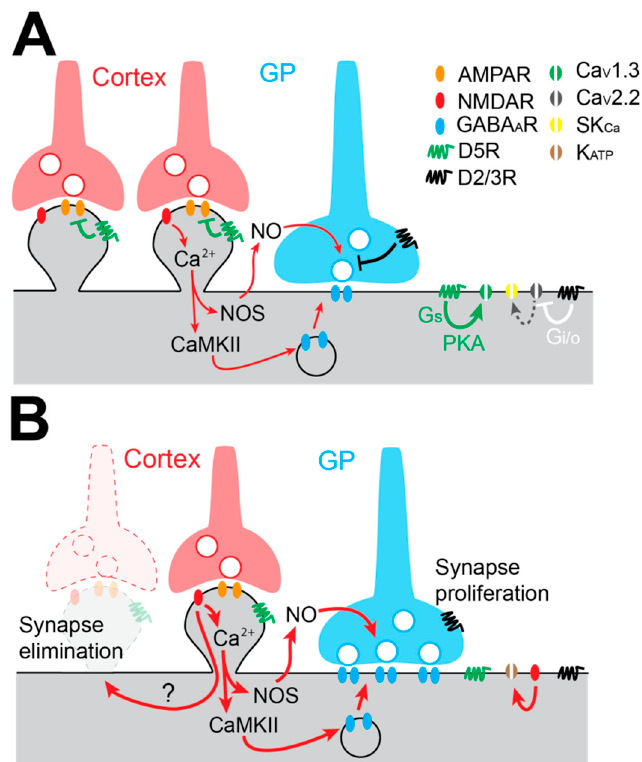
Figure 3. Cellular and synaptic alterations in the STN in experimental PD . ( A ) Schematic of the main post-synaptic and pre-synaptic molecular pathways involved in DA-dependent cellular excitability and synaptic plasticity. ( B ) Under DD conditions, post-synaptic and pre-synaptic DA modulation is lost. This triggers NMDA-dependent M1 cortex synapse pruning, NMDA-dependent